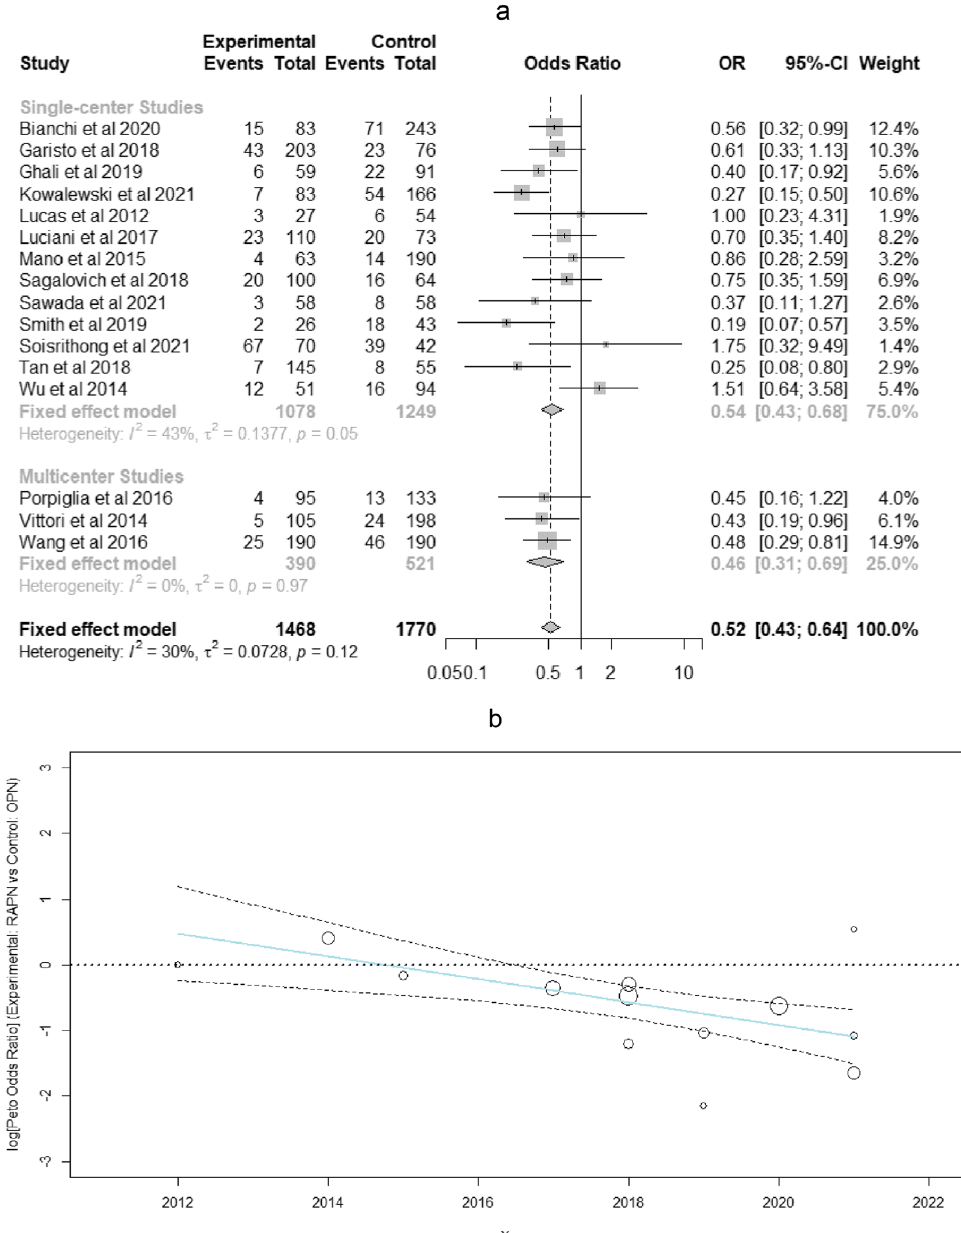
Fig. 5 a: Forest plot under the fixed effects model for the subgroup analysis based on whether each study was performed by a single or multiple centers. A statistically significant reduction in the odds for mild complications in robotic compared to the open approach is demonstrated in both subgroups (for the single-center studies: peto OR 0.54, CI 95% : [0.43; 0.68], and for the multicenter studies: peto OR 0.46, CI 95% : [0.31; 0.69]). b: = = Μ eta-regression analysis bubble plot and regression line, along with its 95% confidence interval, for the annual change in the overall estimate of the effect in log scale, referring to the single-center studies. This graph demonstrates a statistically significant difference between the two approaches that is progressively expanding after 2016. According to this finding, patients undergoing robotic partial nephrectomy are less prone to the development of mild postoperative complications (CD: I and II) compared to those receiving open surgery, with a relative benefit that is broadening over the years. Abbreviations: CD: Clavien–Dindo classification of postoperative